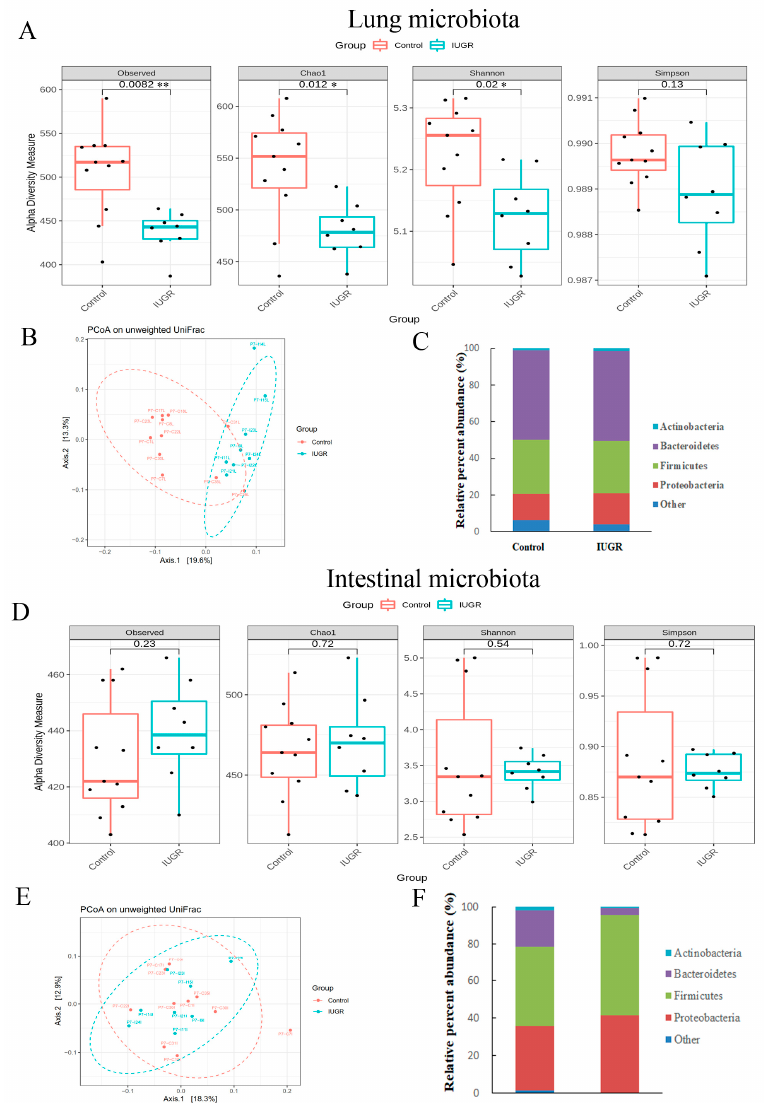
Figure 5. Effect of IUGR on the bacterial phase of offspring rats on postnatal day 7. The α -diversity indices (observed, Chao1 index, Shannon, and Simpson) in the ( A ) lungs or ( D ) gastrointestinal tract. The β -diversity (PCoA on unweighted UniFrac distances) of the ( B ) lungs or ( E ) intestinal tract and the bacterial composition at the phylum level in the ( C ) lungs or ( F ) intestinal tract. Compared with those of the control group, the lung and intestinal microbiota of the IUGR group exhibited significantly lower α -diversity and different β -diversity on postnatal day 7. The α -diversity and β -diversity of the intestinal microbiota did not differ significantly between the two groups. n = 8–10 rats in each group. Data are shown as box-and-whisker plots. * p < 0.05, ** p <